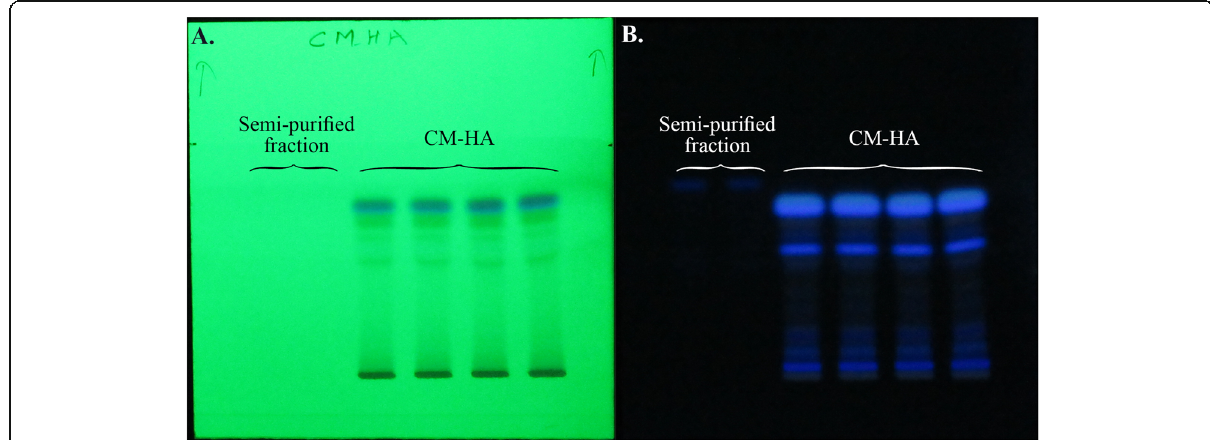
Fig. 4 Visualization of the TLC plates under UV visualizer at 254 nm and 366 nm to detect the presence of different plant secondary metabolites of Citrus maxima (Burm.) Merr